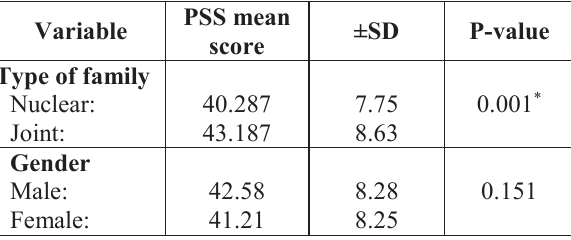
Table-3: Differences across PSS Total score with Type of Family and